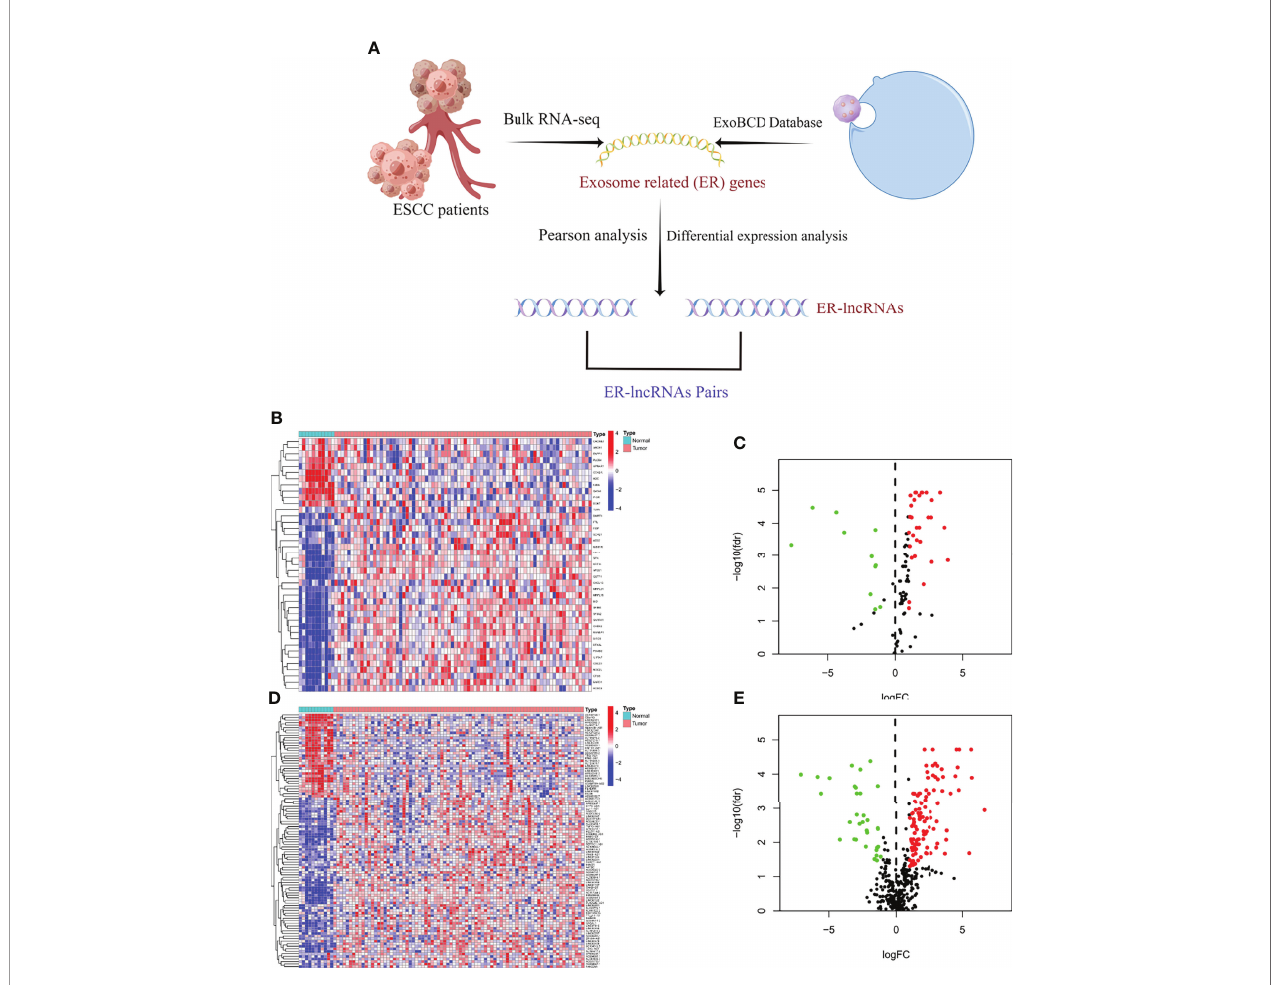
FIGURE 1 | Selection of ER-lncRNAs. (A) The fl ow chart of ER-lncRNA selection. (B, C) Heatmap and Volcano plot of differentially expressed ER-mRNAs between tumor tissues and normal tissues. (D, E) Heatmap and Volcano plot of differentially expressed ER-lncRNAs between tumor tissues and normal